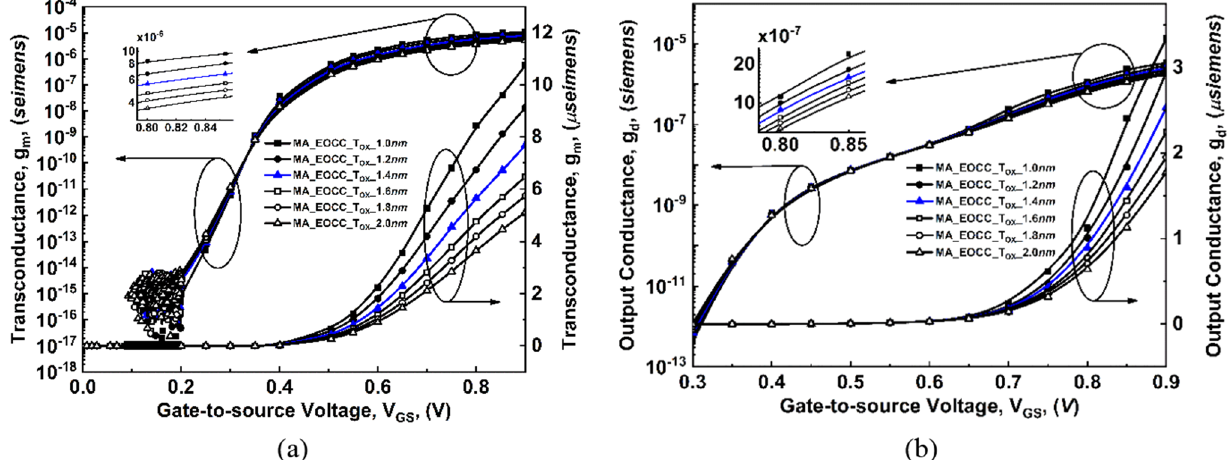
Figure 11. Comparison of variation of transconductance (g m ) and output conductance (g d ) as a function of gate voltage at V DS = 0.3 V for EOCC devices: ( a ) g m , and ( b ) g d .